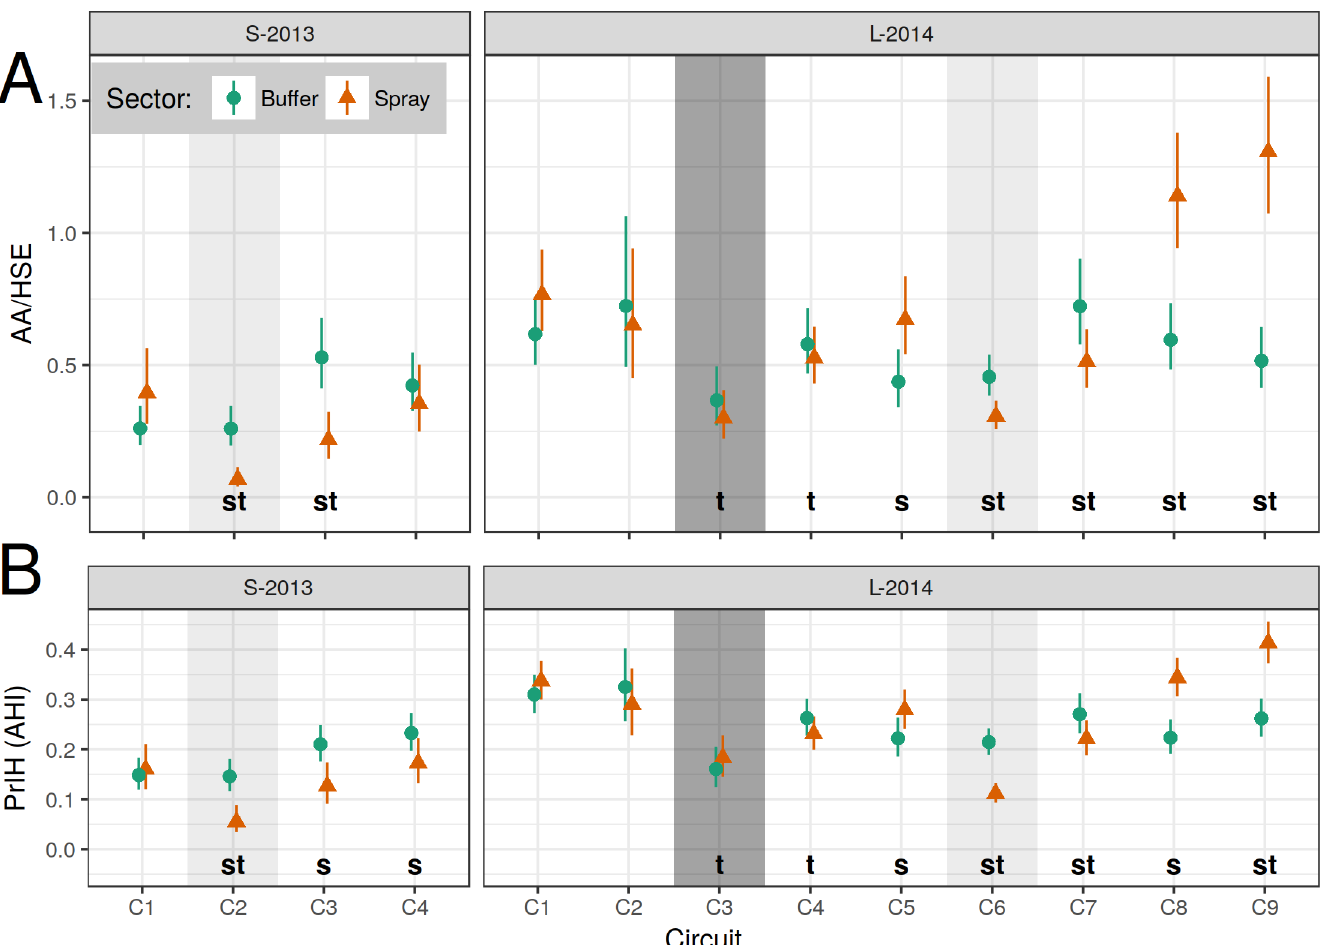
Fig 4. Model estimates of Ae . aegypti adults per house (AA/HSE, top row) and proportion infested houses (PrIH = AHI). A separate generalized linear model (GLM) was constructed for each experiment (column) and for each measured response (row). (A) AA/HSE, negative binomial GLM (NB-GLM). (B) PrIH, logistic GLM (L-GLM). Models describe response of measure (row) to time period (X-axis) and treatment sector (color & shape). Shading indicates spray events: experimental spraying (light) and citywide spraying (dark). Vertical bars show 95% CI; non-overlapping CI indicate highly significant difference. Letters (s, t) indicate significant differences between pairwise contrasts: s, between sector (within time, S2 Table); t, between time (within spray sector, relative to baseline C1, S3 Table). See also S6A and S6B Table, S7A and S7B Table, and S5